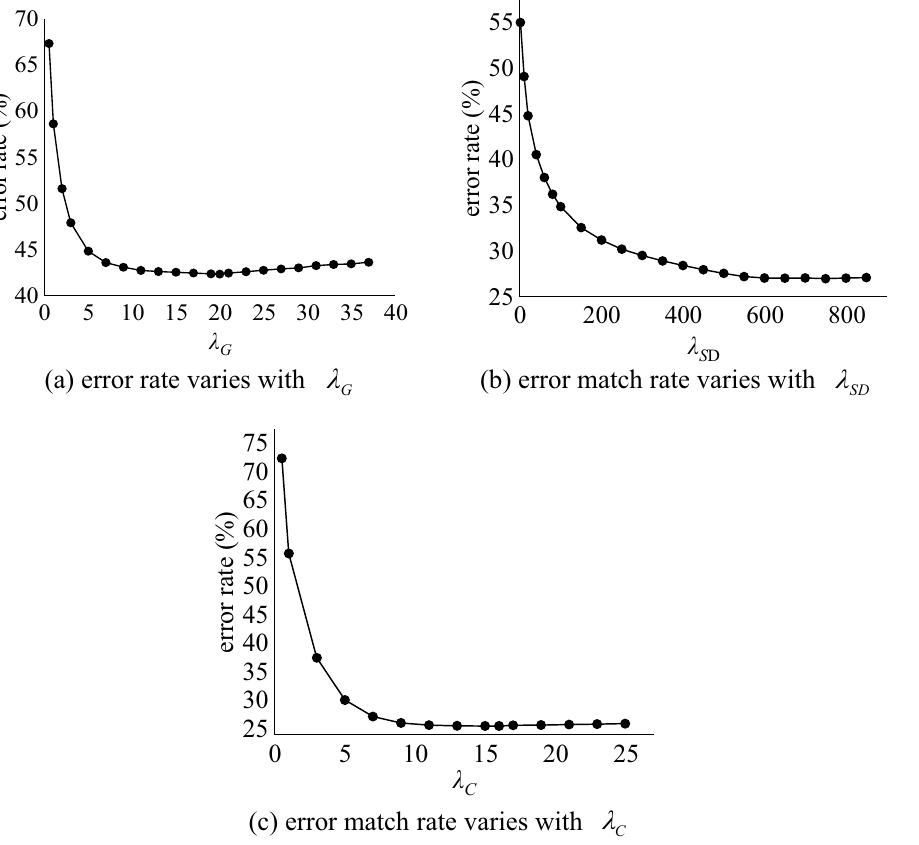
Figure 6. The effect of parameter changes on the error rate.